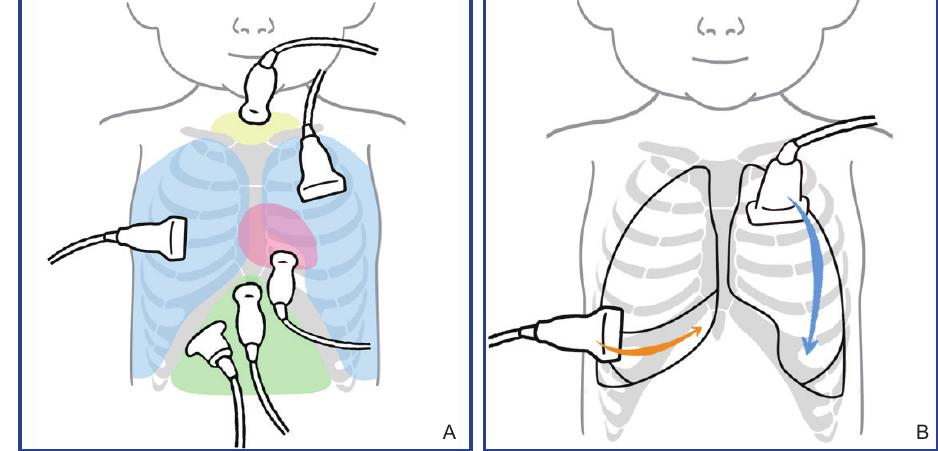
Figure 2 Schematic diagram of the body surface partition of the lung scan. (A) Transthoracic lung surface scan (blue), subcostal scan (green), parasternal precordial area scan (red), and trans sternal scan (yellow); (B) Transthoracic scan technique: The probe is vertical to the chest wall surface, moving and swinging the probe, the longitudinal section moves laterally (orange arrow), and the transverse section moves up and down (blue arrow).